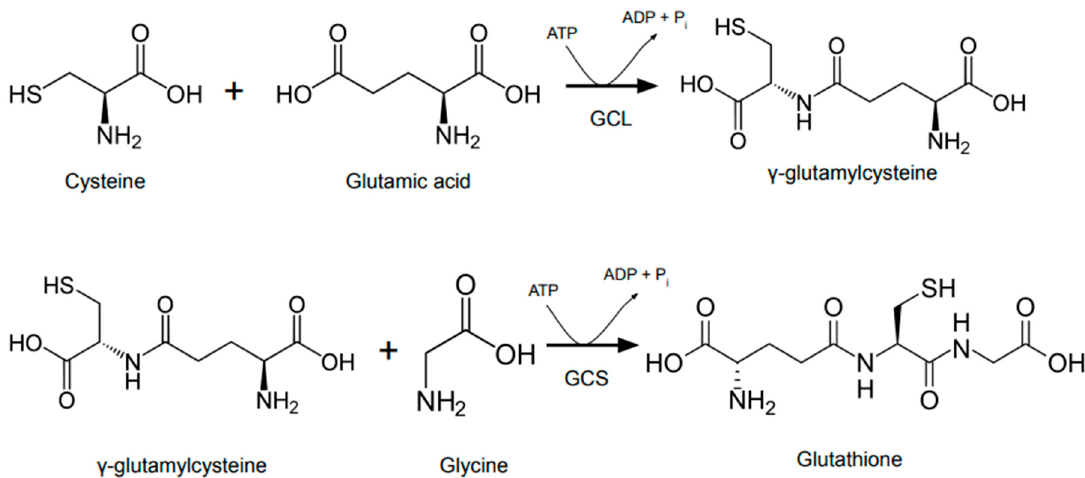
Figure 1. Two step de novo synthesis of glutathione. First step is catalyzed by glutamate-cysteine ligase (GCL) and is considered the rate limiting step. Glutamyl cysteinyl glycine synthase (GCS) catalyzes the second step. Both steps require ATP.